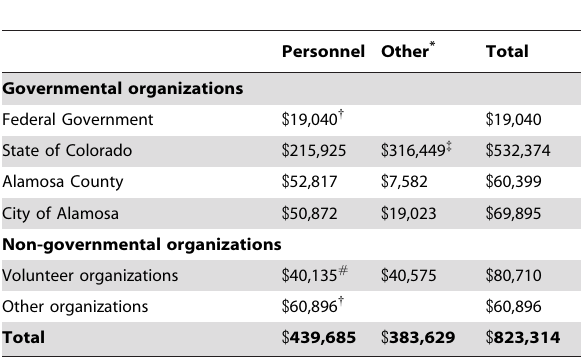
Table 7. Outbreak response costs associated with an outbreak of salmonellosis, Alamosa, Colorado 2008.